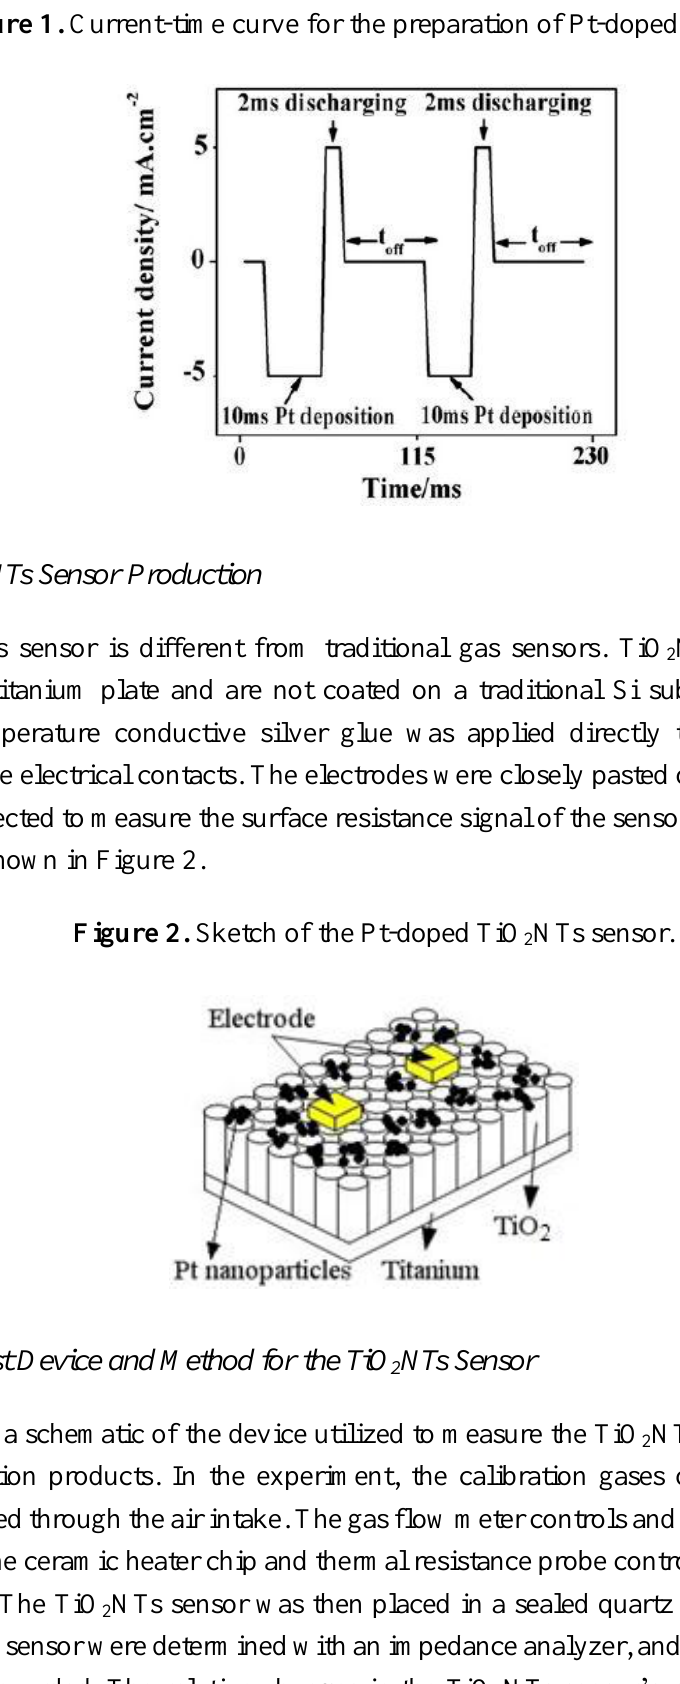
Figure 1. Current-time curve for the preparation of Pt-doped TiO